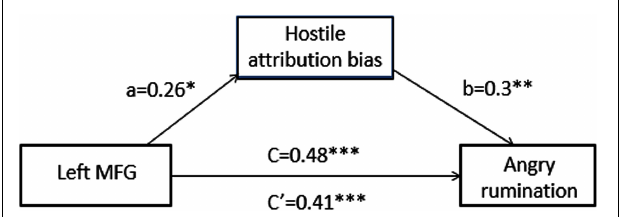
FIGURE 2 | Hostile attribution bias mediates the association between brain structure and angry rumination: path diagram of the mediation analysis demonstrating that the left-MFG affected individuals’ angry rumination through hostile attribution bias. Total effect (c): b = 0.48, SE = 0.09, p < 0.001. Direct effect (c (cid:48) ): b = 0.41, SE = 0.09, p < 0.001. Indirect effect (ab): b = 0.08, Boot SE = 0.04, 95%CI = [0.02, 0.18]. ∗ p < 0.05; ∗∗ p < 0.01; ∗∗∗ p <